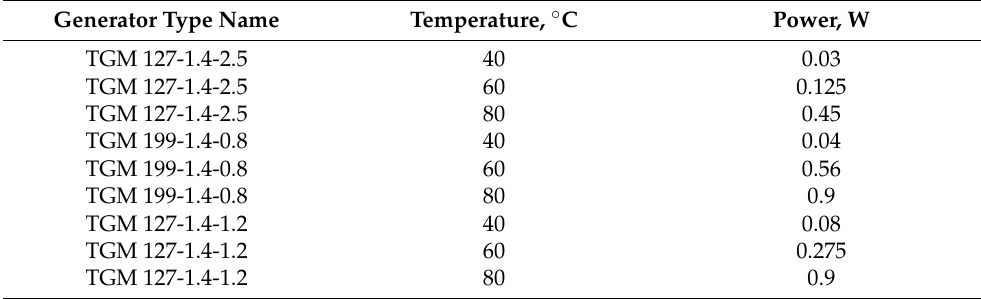
Table 4. Parameters of the dependence of the output power on the temperature of the heat transfer surface for the 3 types of thermoelectric modules.